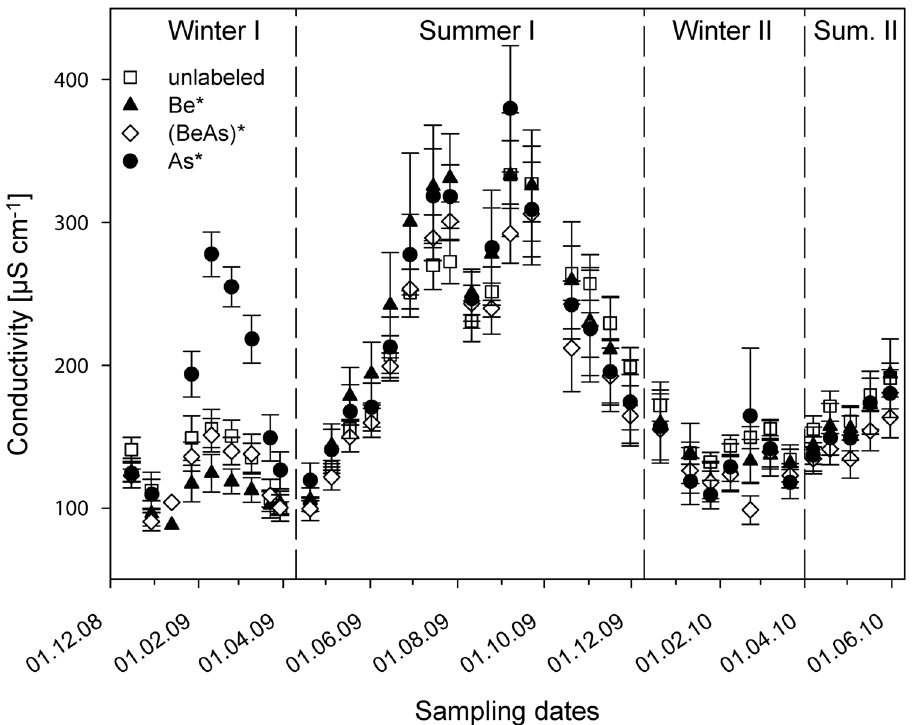
Figure 5. Measured conductivities (mean values ¡ standard error) in soil water under treatments with only labeled beech (Be*; n 5 6), labeled ash (As*; n 5 6), mixed ((BeAs)*; n 5 12) and unlabeled litter treatments (unlabeled; n 5 18). The dashed lines subdivide the experiment into the two winter (I: 16.12.08– 30.03.09; II: 21.12.09–22.03.10) and two summer periods (I: 20.04.09–30.11.09; II: